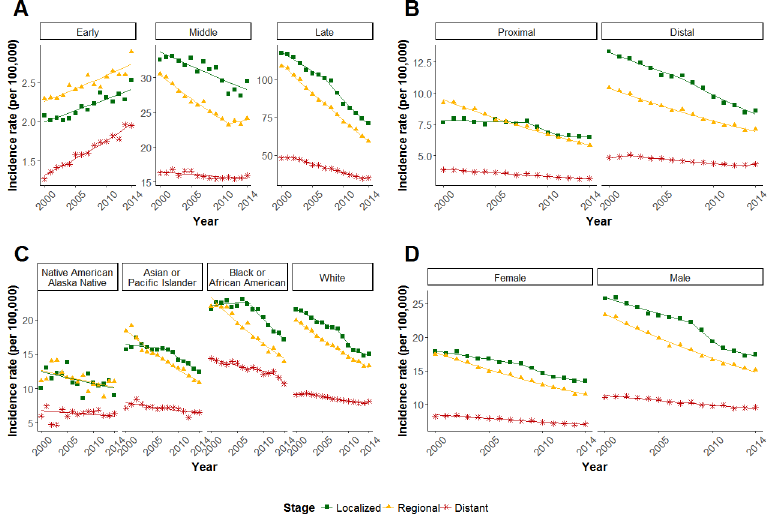
Fig 3. Incidence rates of distant, regional, and localized CRC by age, sex, site, and race. Change in the incidence rates (per 100,000) of CRC by stage stratified by (A) age ( < 50, 50–64, 65+), (B) site (distal, proximal), (C) race (Native American/Alaskan Native, Asian or Pacific Islander, Black or African American, and White), and (D) sex. Green squares, localized; yellow triangles, regional; red stars, distant.